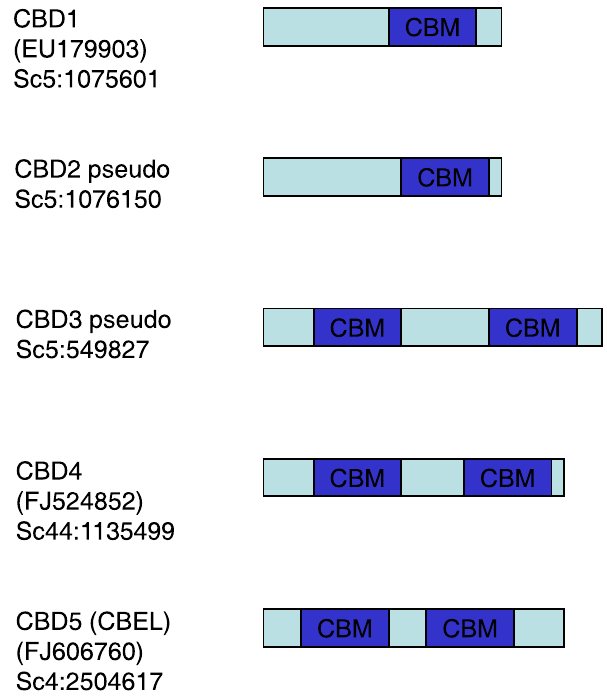
Figure 1. Identification of Phytophthora infestans genomic regions encoding the cellulose binding domain (Carbohydrate Binding Module 1) motif. The CBD2 and CBD3 gene regions have no corresponding ESTs.